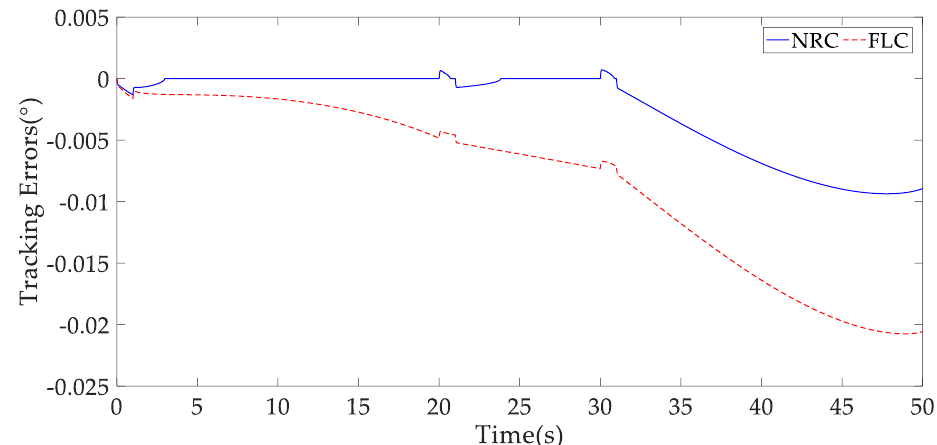
Figure 9. The tracking errors of three controllers.